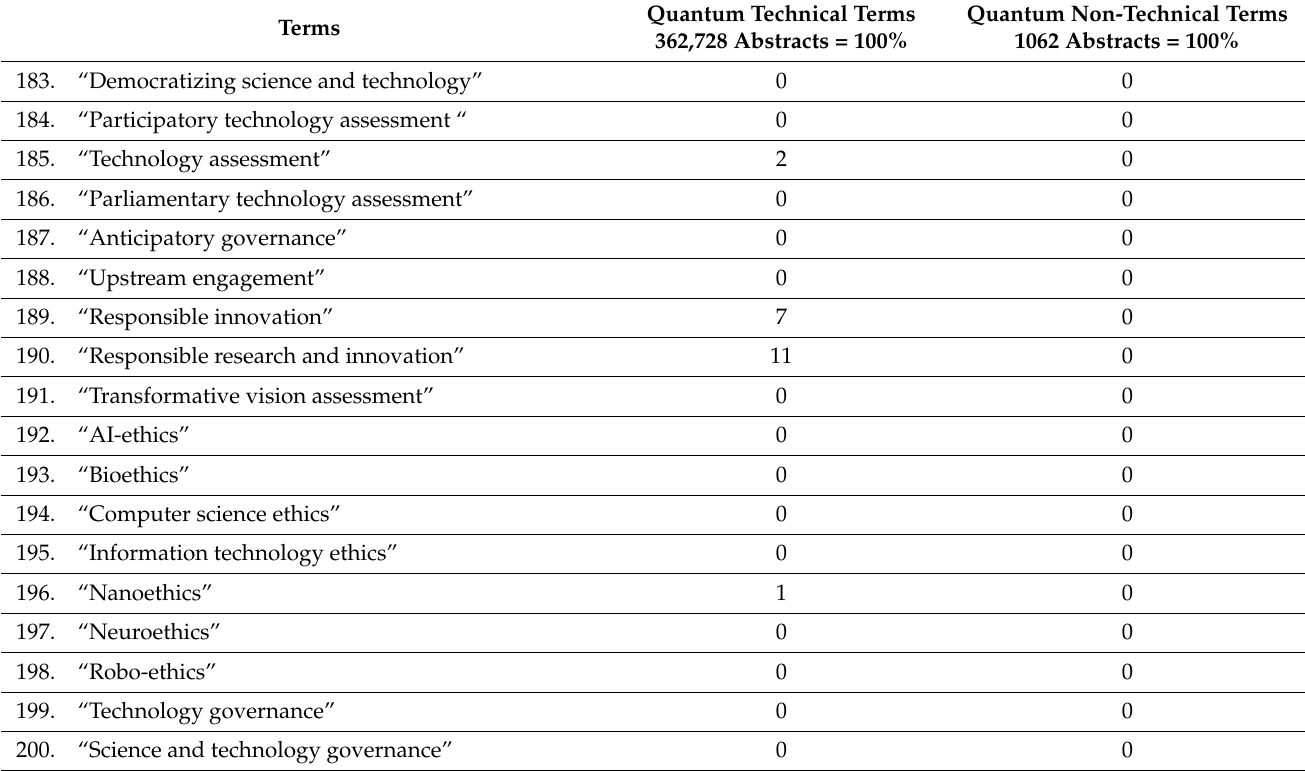
Table 10. Presence of science and technology governance terms in the academic literature focusing on quantum technologies.